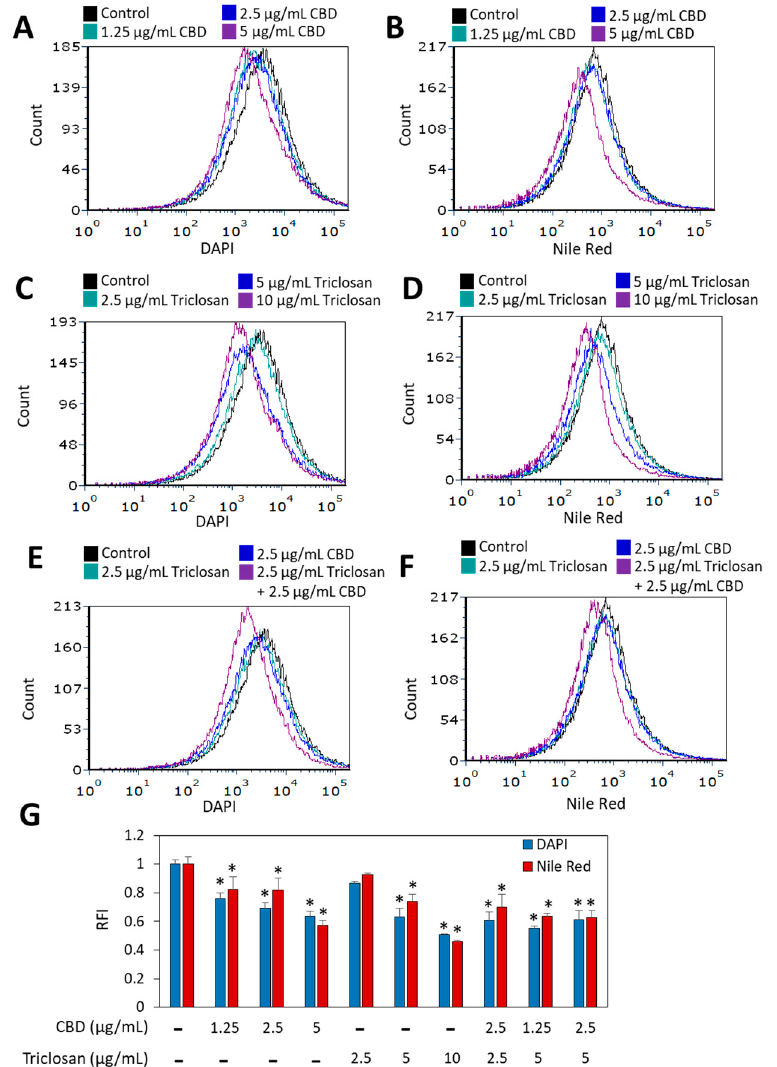
Figure 4. CBD and triclosan reduced both DAPI staining and Nile red staining of S. mutans after a 1 h incubation. ( A – F ) Flow cytometry of DAPI ( A , C , E ) and Nile Red ( B , D , F ) fluorescence intensities of S. mutans that was treated with the indicated concentrations of triclosan and CBD for 1 h. ( G ) The average relative fluorescence intensity (RFI) of DAPI and Nile Red in the control and treated bacteria. * p < 0.05 compared to control bacteria. N = 3.